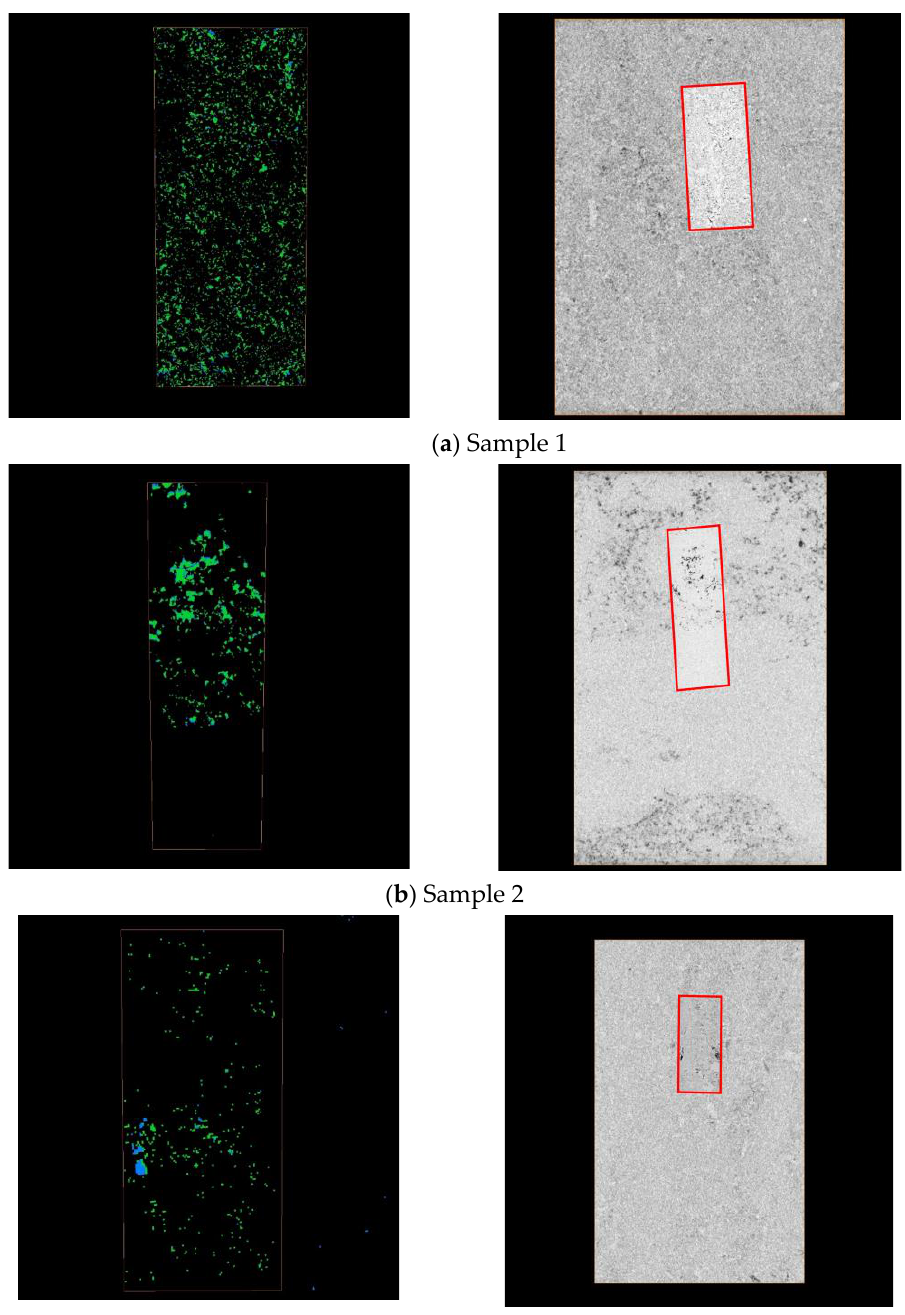
Figure 6. Results of Computed Tomography for ( a ) Sample 1, ( b ) Sample 2, and ( c ) Sample 3. Green and blue colors on the left pictures show the pores seen, respectively, within big and small samples. The dashed contours on the left indicate the area of small sample. The pictures on the right exemplify the places for cutting the small samples.